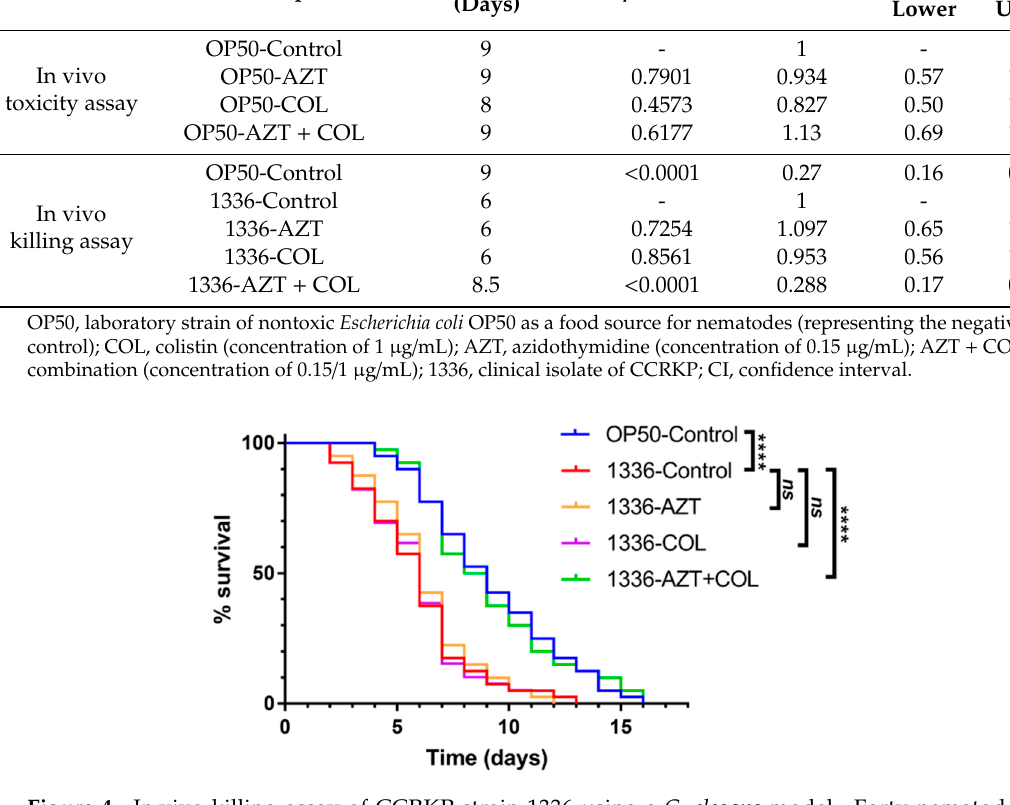
Figure 4. In vivo killing assay of CCRKP strain 1336 using a C. elegans model. Forty nematodes were infected with CCRKP clinical strain 1336 (isolated from blood) and supplemented with a vehicle (control), colistin (COL, at 1 µ g / mL), azidothymidine (AZT, at 0.15 µ g / mL), or a combination (AZT + COL, at 0.15 / 1 µ g / mL). ns, no significance; ****, p < 0.0001. Table 5. Statistical analyses of in vivo C. elegans toxicity testing and killing assays.